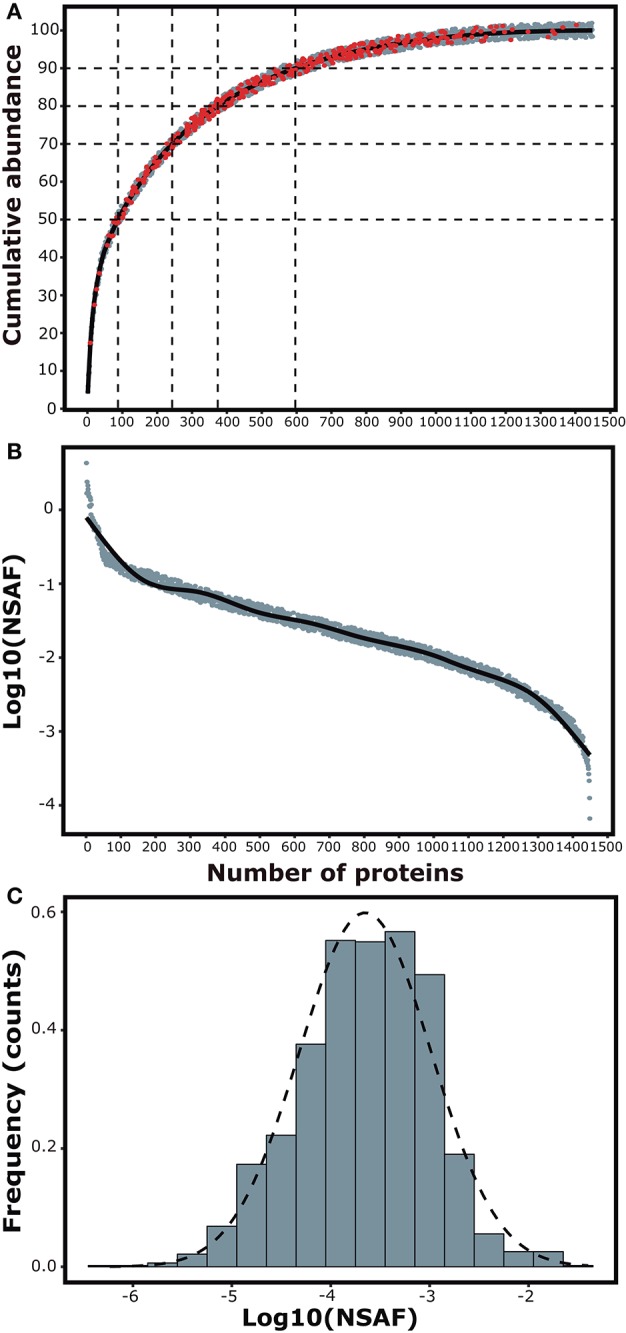
Composition analyses of the spleen proteome. (A) Cumulative abundance plot shows the total number of identified proteins in ascending order in relation to their mass contribution to the spleen proteome. Red dots represent differentially expressed proteins. (B) Dynamic abundance plot showing the variability in abundance of the identified proteins. (C) Histogram for the frequency distribution of protein abundance in the samples.